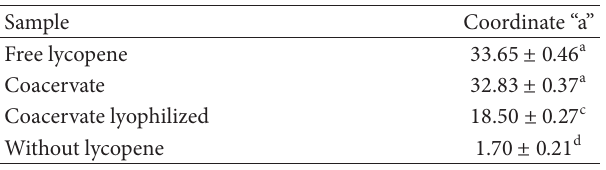
Table 4: Values of coordinates “a” for cakes produced with lycopene in different means and without